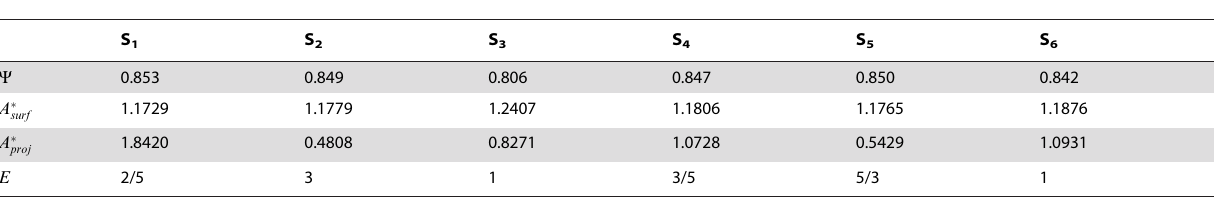
Table 1. Parameters of sand particles with different